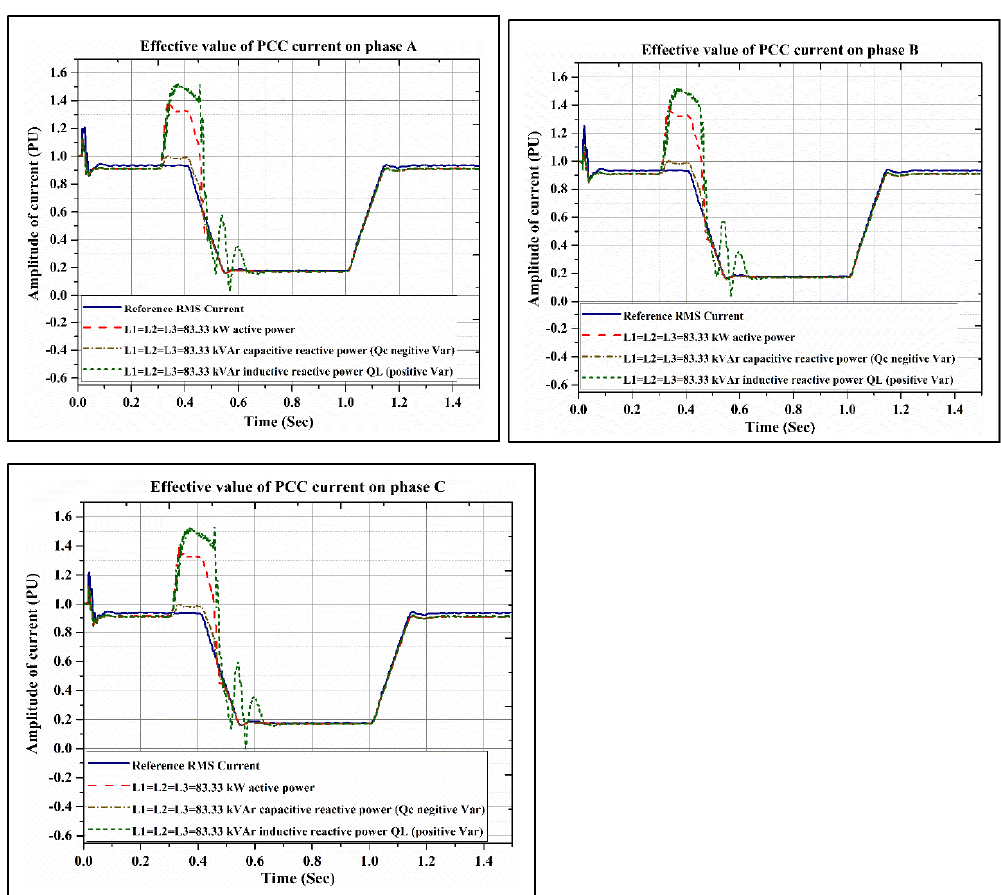
Figure 9 . The effective value of PCC voltage when local loads match with local generation.